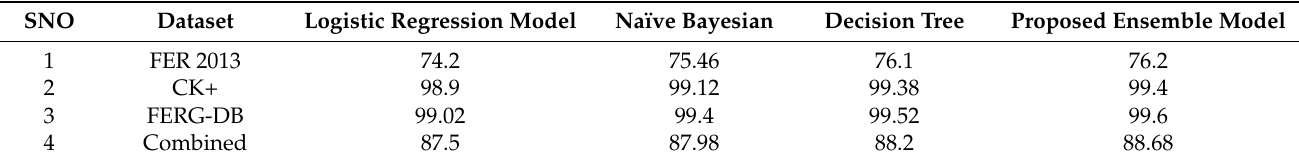
Table 4. Classification accuracy of the individual classifiers on the three